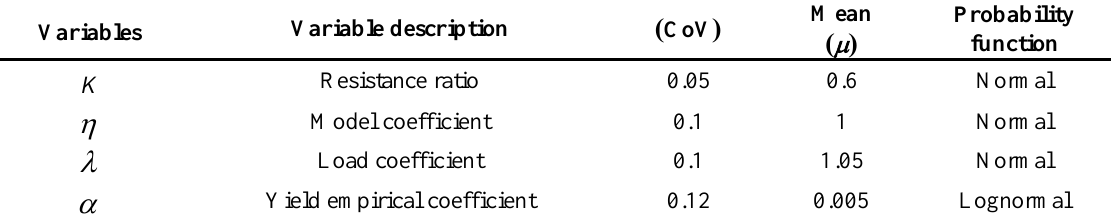
Table 2. Statistical characteristics of the model, resistance and load uncertainties